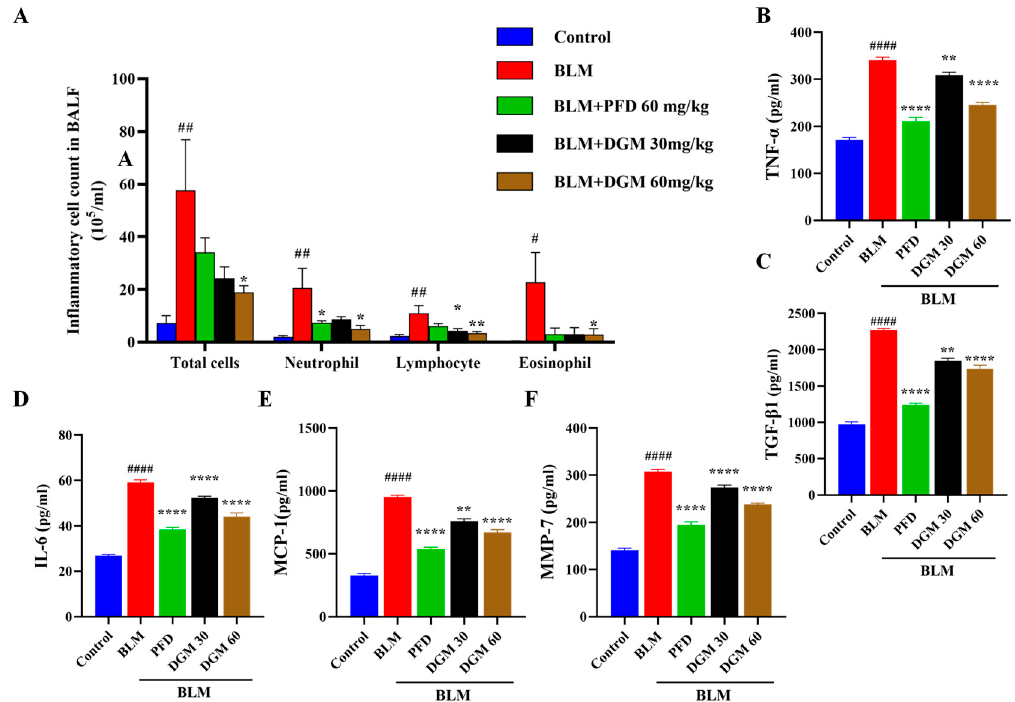
Figure 7. DGM can reduce the content of inflammatory cells and inflammatory cytokines in the rat BALF. ( A ) Twenty-four hours after the last administration, total inflammatory cells, neutrophils, lymphocytes, and eosinophils were counted in the BALF. ( B ) TNF- α , ( C ) TGF- β 1, ( D ) IL-6, ( E ) MCP-1, and ( F ) MMP-7 levels of the BALF. Data represent the mean ± SEM ( n = 6). # p < 0.05, ## p < 0.01, #### p < 0.0001 vs. control group; * p < 0.05, ** p < 0.01, **** p < 0.0001 vs. BLM group.